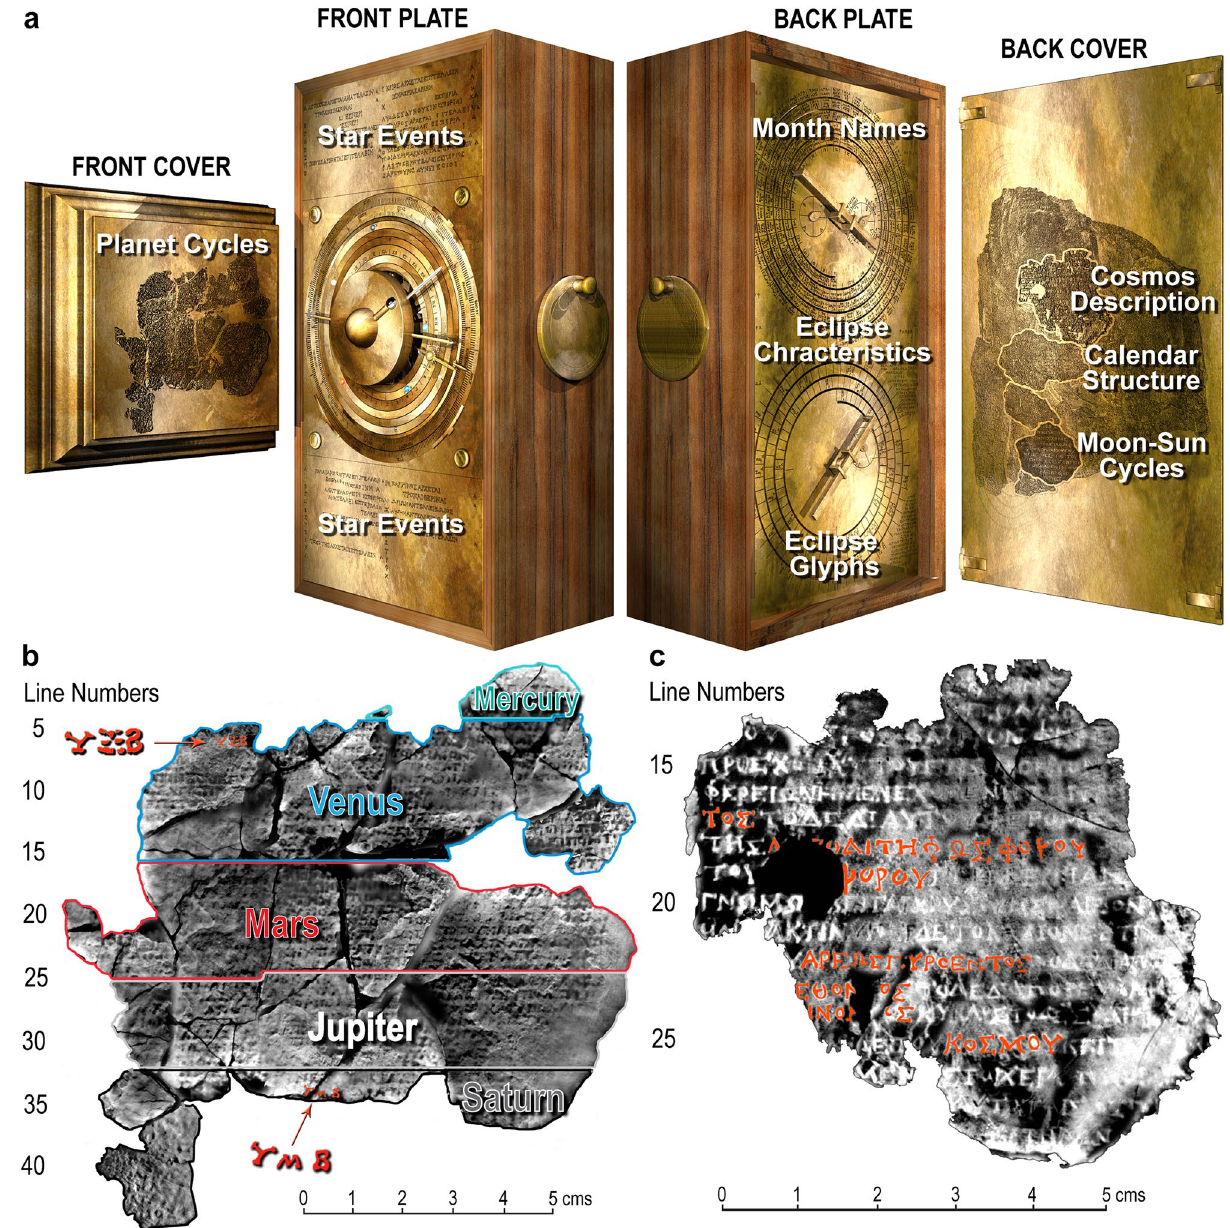
Figure 1. Inscriptions on the Antikythera mechanism. ( a ) FRONT COVER: Planet cycles 9,12 , framed by moulding from Fragment 3 (Supplementary Fig. S5). FRONT PLATE: Parapegma 1,2,25 , above and below the Cosmos Display, indexed to the Zodiac Dial. BACK PLATE: Month names on the Metonic Calendar 4,8 . Eclipse characteristics, round Metonic Calendar and Saros Eclipse Prediction Dials 7,8 —indexed to the latter. Eclipse glyphs indexed to the Saros Dial 8 . BACK COVER: User Manual , including Cosmos description 9,13 (Supplementary Discussion S2), Calendar Structure 8 and Moon-Sun Cycles 1,2 . ( b ) Front Cover Inscription (FCI): composite X-ray CT from Fragments G, 26 and 29 and other small fragments 9,12 . The FCI describes synodic cycles of the planets and is divided into regions for each planet in the CCO (Supplementary Discussion S2). The numbers ϒ ΞΒ (462) in the Venus section and ϒ MΒ (442) in the Saturn section are highlighted 12 (Supplementary Fig. S4). ( c ) Back Cover Inscription (BCI) 13 (Supplementary Discussion S2): composite X-ray CT from Fragments A and B. A User Manual : the upper part is a description of the front Cosmos Display 9 with planets in the CCO; in red are the planet names as well as the word KOΣMOY—“ of the Cosmos